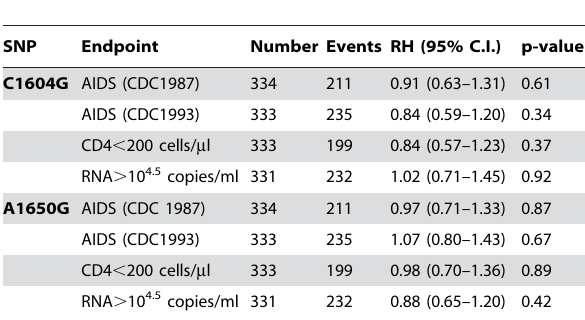
Table 2. Effects of CypA SNPs C1604G and A1650G on disease progression in the Amsterdam cohort of MSM.